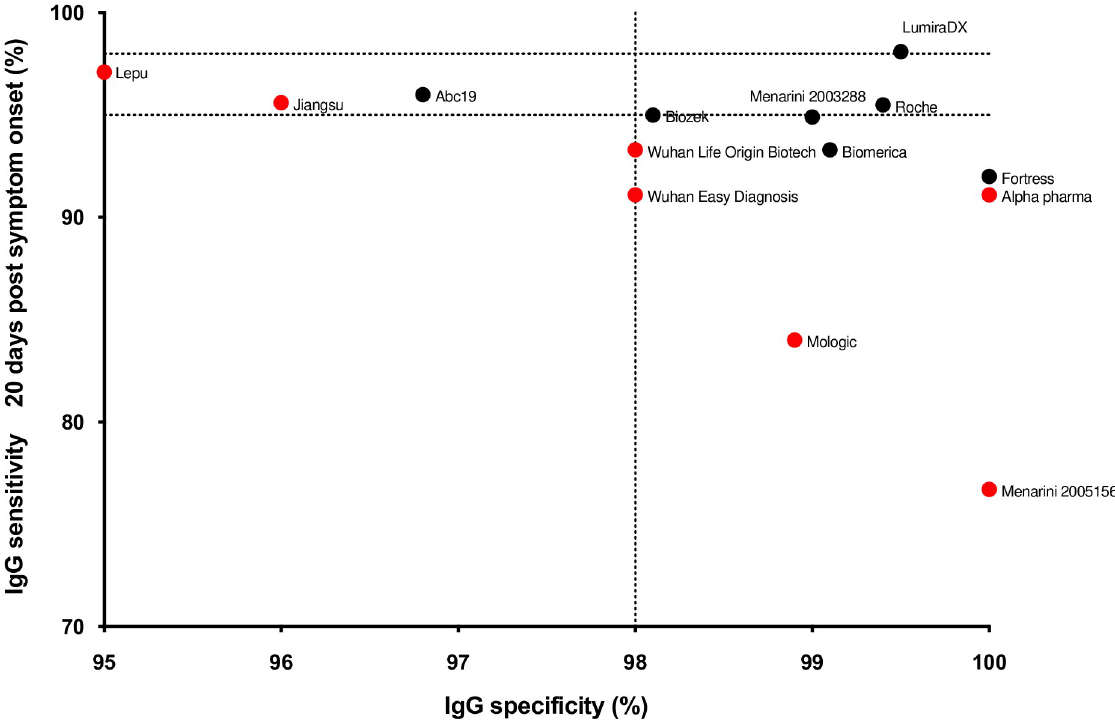
Fig 1. Sensitivity vs specificity at � 20 days. Sensitivity against specificity for the kits tested (IgG only, and positive or negative result for the LumiraDx assay). For each kit the � 20 days post symptom onset sensitivity is shown. The MHRA targets of 98% sensitivity and specificity and additional 95% sensitivity cut off are shown as dotted lines. Pharmact was not included on the graph due to low specificity. The devices that did not progress beyond this stage are shown in